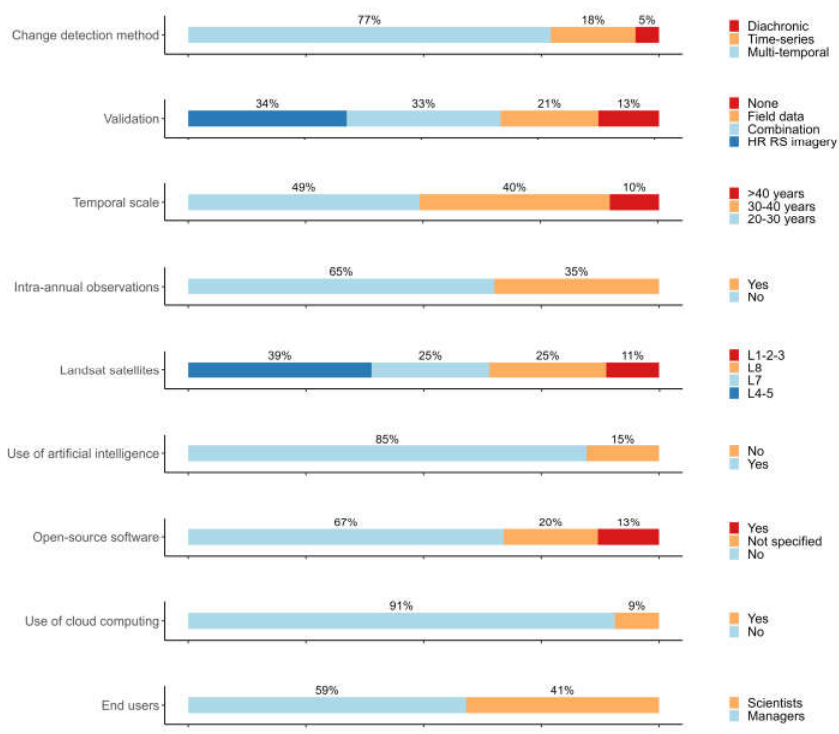
Figure 6. Distribution of the reviewed studies according to categories of Landsat data analysis.